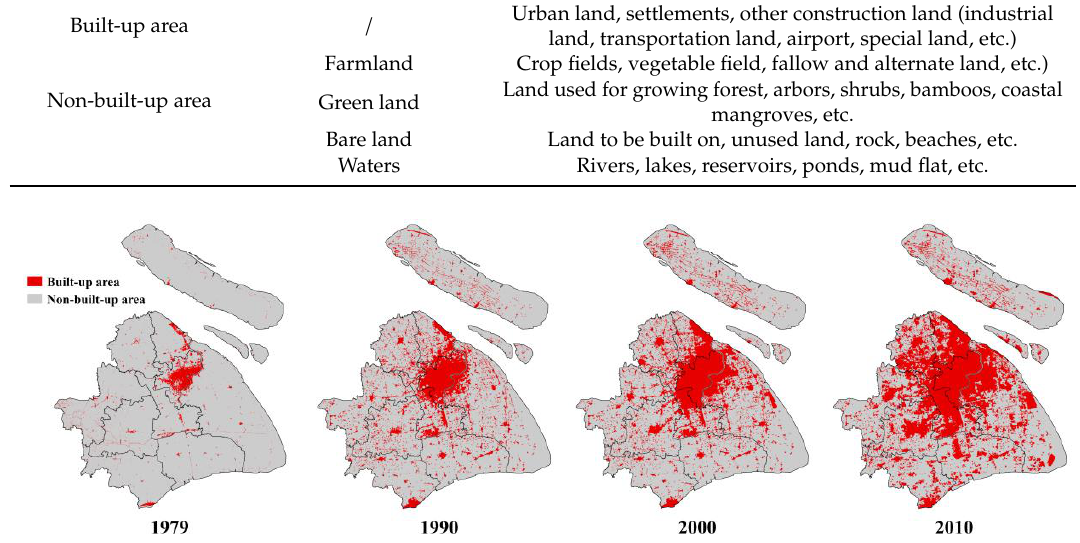
Figure 2. Spatiotemporal distributions of built-up and non-built up areas in Shanghai.